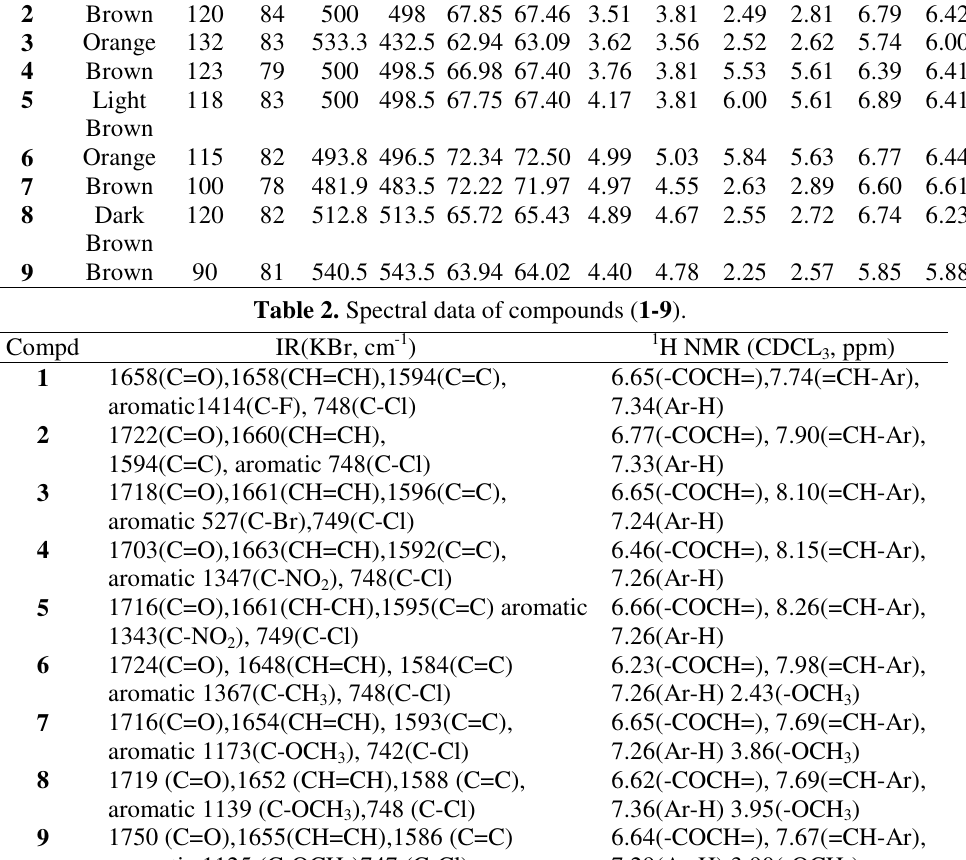
Table 1 . Physical and analyses data of compounds ( 1-9 ).